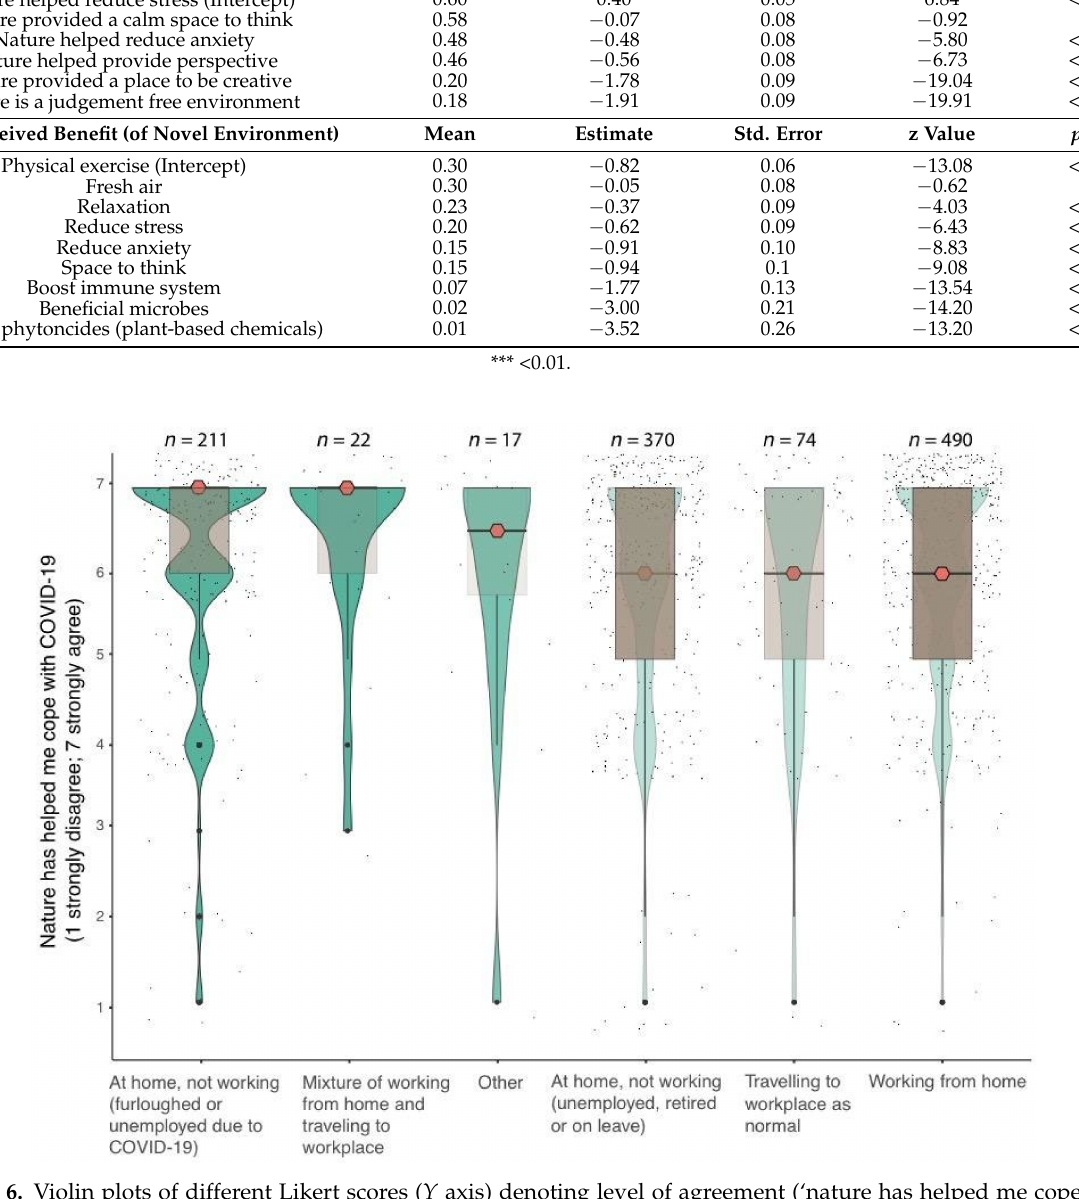
Figure 6. Violin plots of different Likert scores ( Y axis) denoting level of agreement (‘nature has helped me cope with COVID-19’) analysed by home/work situations ( X axis). Plots display median values (red diamond), interquartile range (brown) and kernel density estimation (green). The strength of the kernel colour corresponds to the median value, and the strength of the boxplot colour corresponds to the sample